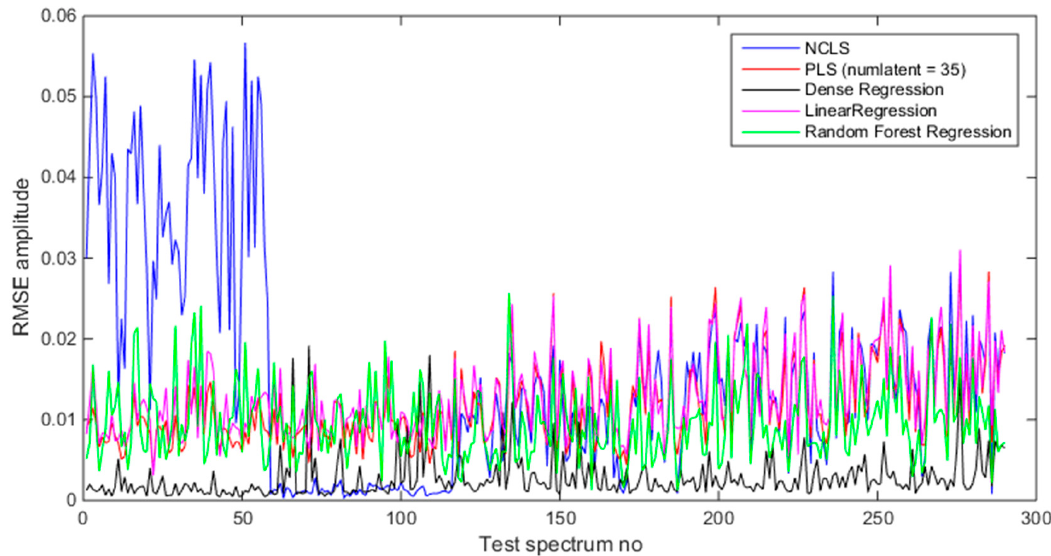
Figure 16. Mixing ratio estimation results when using source ‐ only spectra (foreground − background).